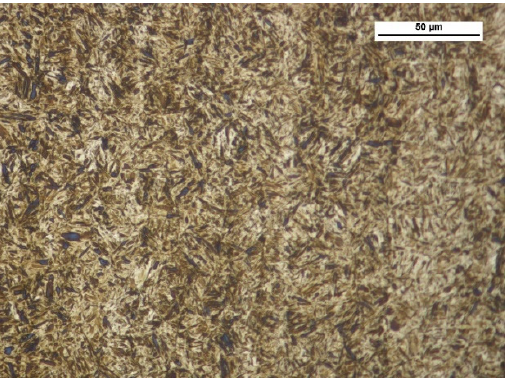
Figure 3. XAR 600 steel microstructure—tempered martensite. Magnitude ×500, etched with 3% HNO 3 (Mi1Fe), scanning microscopy.